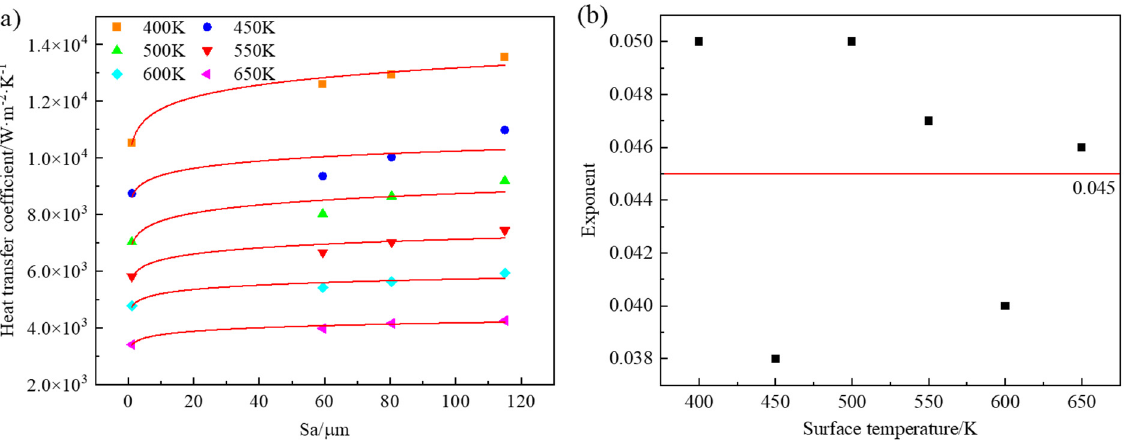
Figure 13. The relationship between HTC and roughness at free − falling zone, including regression analysis ( a ) and exponential mean value ( b ).